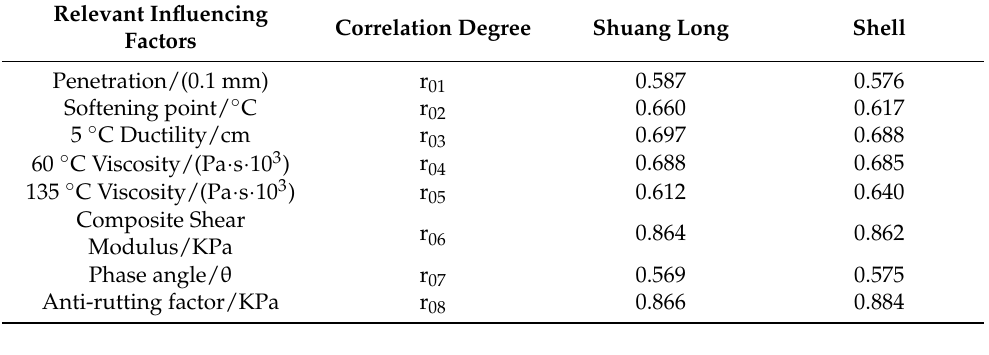
Table 8. Correlation degree of ZSV and the other properties.